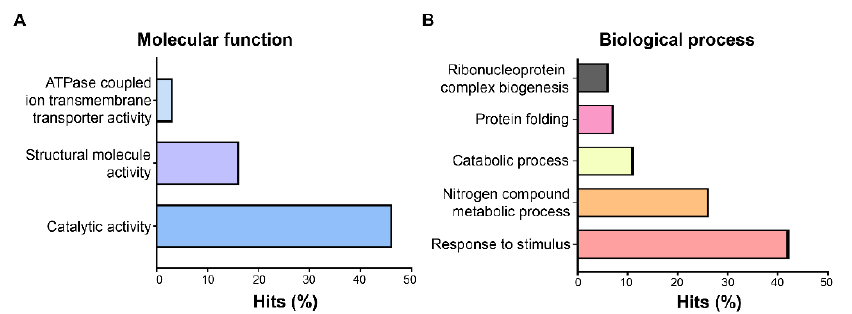
Figure 3. Functional characterization of identified proteins involved using GO-enrichment analysis. Bar charts showing functional categories of the 182 classified hits in molecular function ( A ) and biological process ( B ) categories using AgriGO v2.